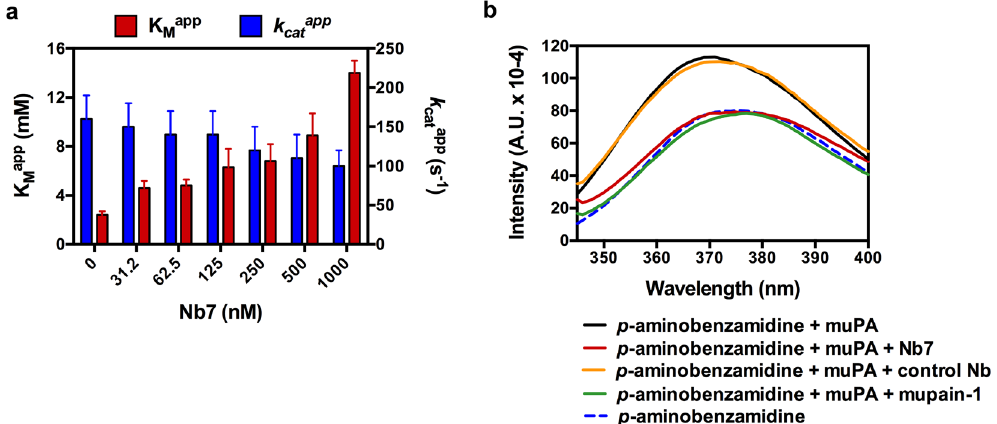
Figure 4. Characterization of the anti-muPA nanobody Nb7. ( a ) Determination of the apparent substrate affinity K Mapp and turnover number k catapp for muPA hydrolysis of the chromogenic substrate pyro-Glu-Gly-Arg- pNa in the absence or presence of Nb7. Error bars, s.d. (n = 3 independent measurements). ( b ) Fluorescent spectra of p -aminobenzamidine in the absence or presence of full-length muPA, Nb7, a control nanobody or the active site binding peptide mupain-1. The curves are representatives of three independent measurements.